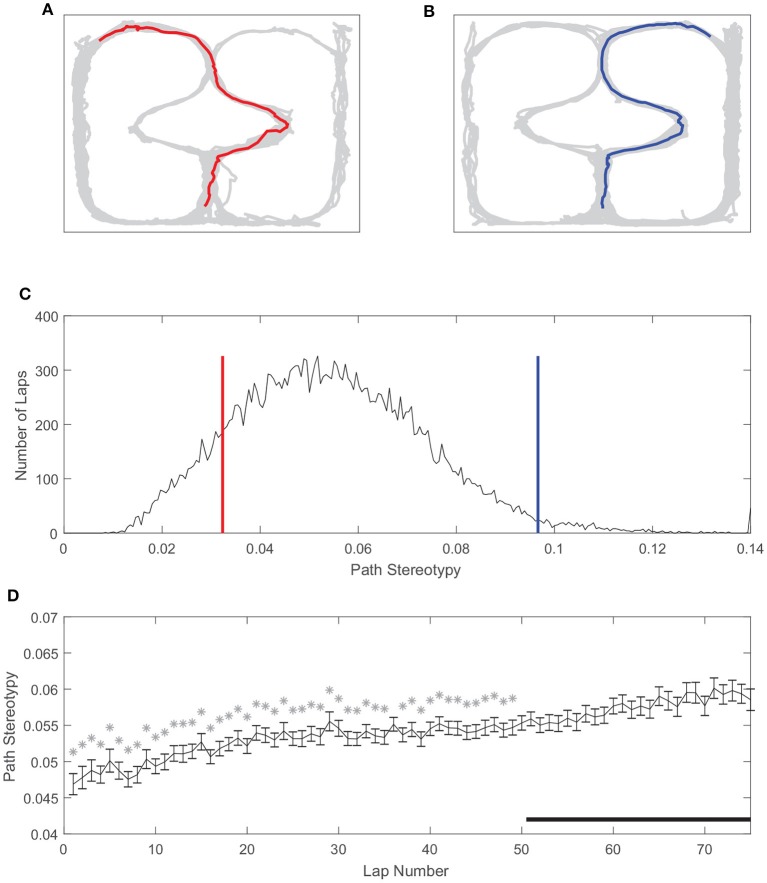
Path stereotypy on the spatial two-step task. (A) An irregular, non-stereotyped path, and (B) an example of a highly stereotyped path. The gray line is rat body position over the whole session, and colored lines are the rat body position on the example lap. (C) Distribution of path stereotypy over all laps, sessions, and rats. Red line corresponds to the log deviation value of the example lap shown in (A), blue line to the example lap shown in (B). (D) Path stereotypy over the course of a session. Stars indicate laps for which path stereotypy was significantly less than that of laps 51 and greater. Data has been aggregated over rats (N = 357, the total number of sessions). Error bars show SEM.